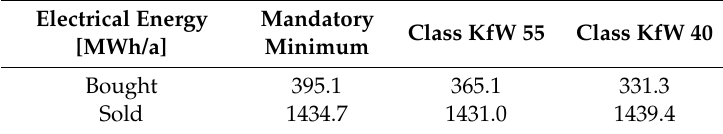
Table 9. Electrical energy fed into and purchased from the grid in one year.